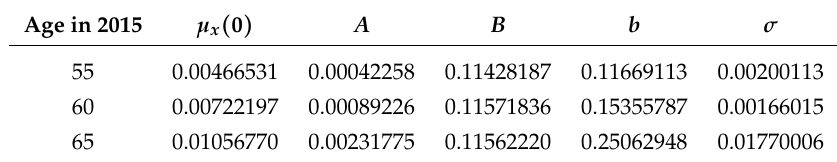
Table 1. Optimal parameters value for the different cohorts, HW model.